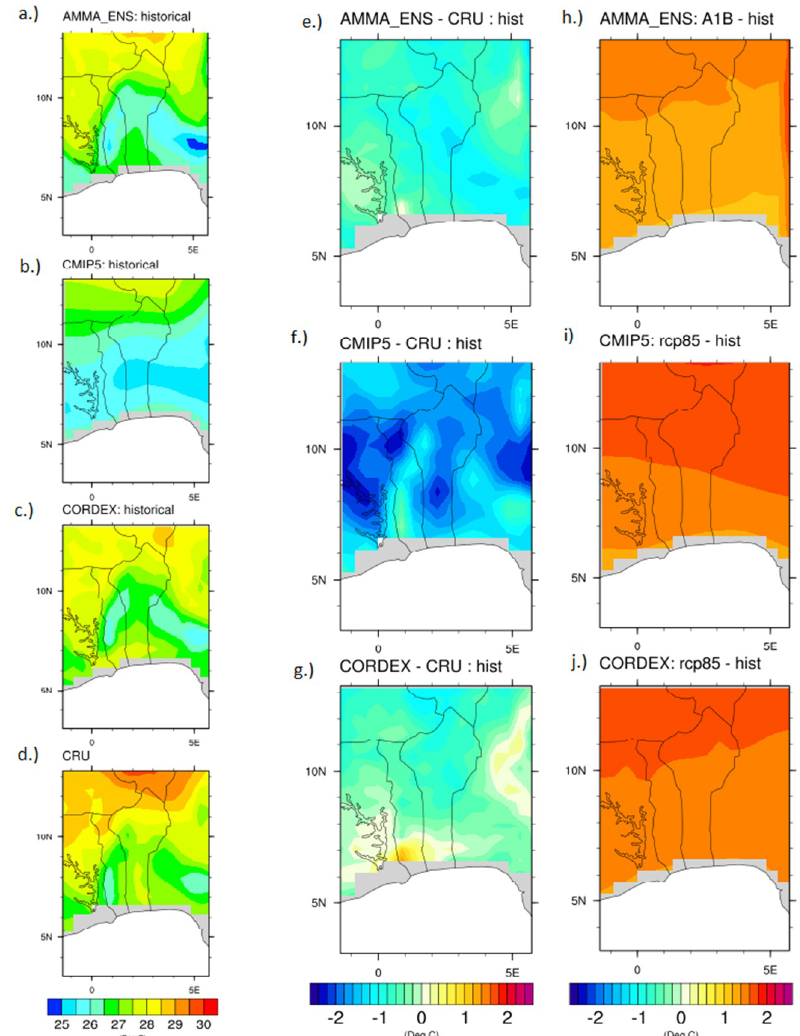
Figure 3. Ensemble average annual mean temperature for 1988–2005 (first column), validation (second column over 1988–2005 period), and the projected changes with respect to the period 2028–2050 (third column).